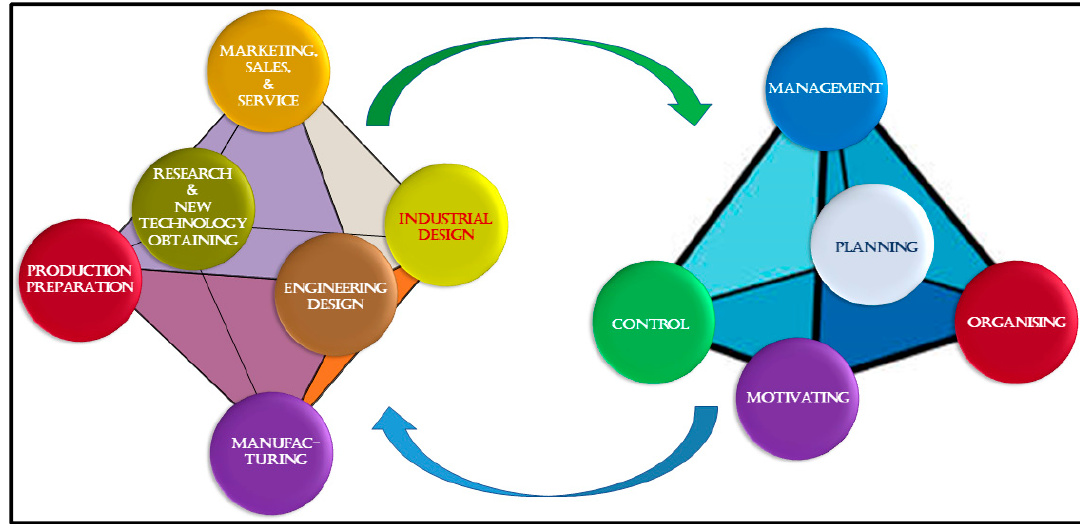
Figure 4. General model of manufacturing engineering with a reactive general management model related to it, e.g., in this sphere.